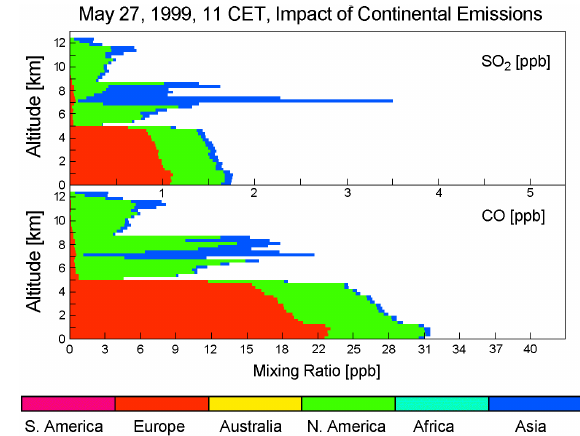
Fig. 12. Vertical distribution of FLEXPART SO 2 and CO emis- sion tracers from the different source continents above Garmisch- Partenkirchen, calculated for the time of the lidar measurement on 27 May 1999, shown in Fig. 8c (twenty-day simulation); Asian in- fluence is found in the altitude range around 8km.